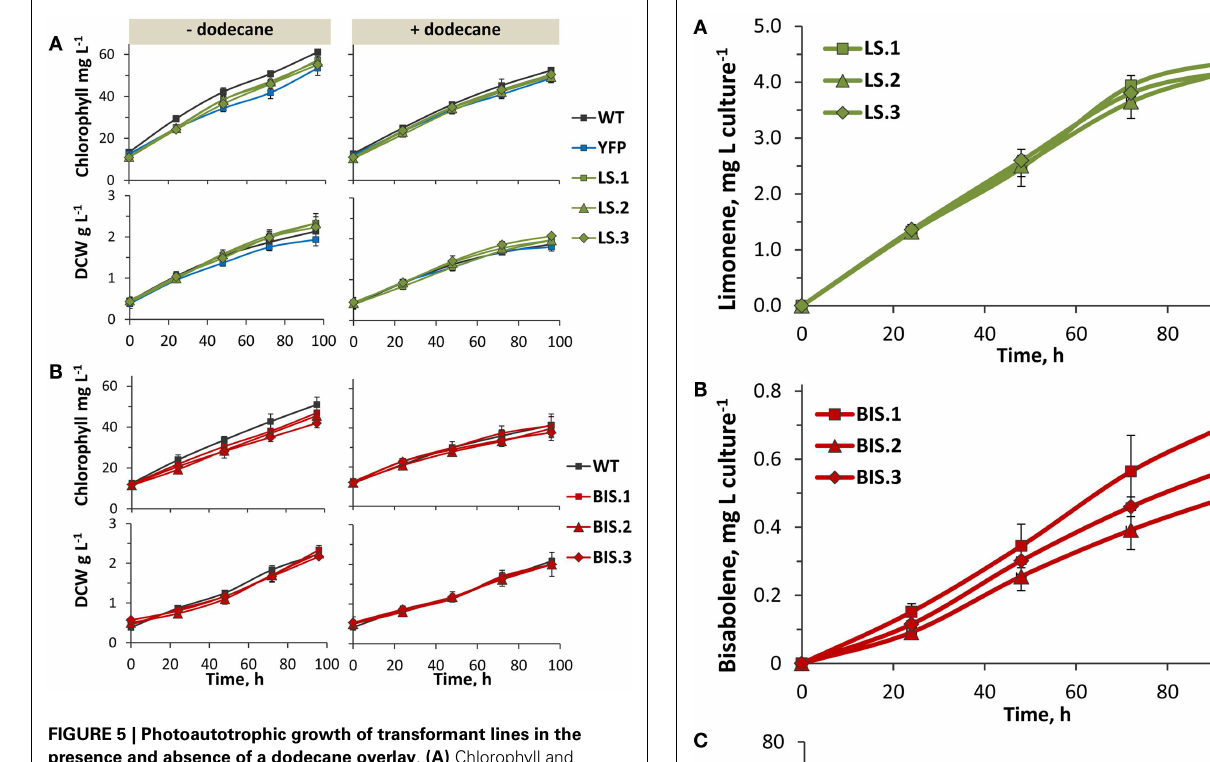
FIGURE 5 | Photoautotrophic growth of transformant lines in the presence and absence of a dodecane overlay . (A) Chlorophyll and biomass accumulation [as measured by dry cell weight (DCW)] over 96h in theYFP control strain, and three independent LS lines (LS.1, LS.2, and LS.3) in comparison to wild type. Left panels show growth in the absence of a solvent overlay, while right panels display growth in the presence of a dodecane overlay. (B) Comparison of chlorophyll and biomass accumulation (DCW) between wild type and three independent BIS transformant lines (BIS.1, BIS.2, and BIS.3), in the absence (left panels) and presence (right panels) of a dodecane overlay. Error bars represent standard deviation from at least three biological replicates.